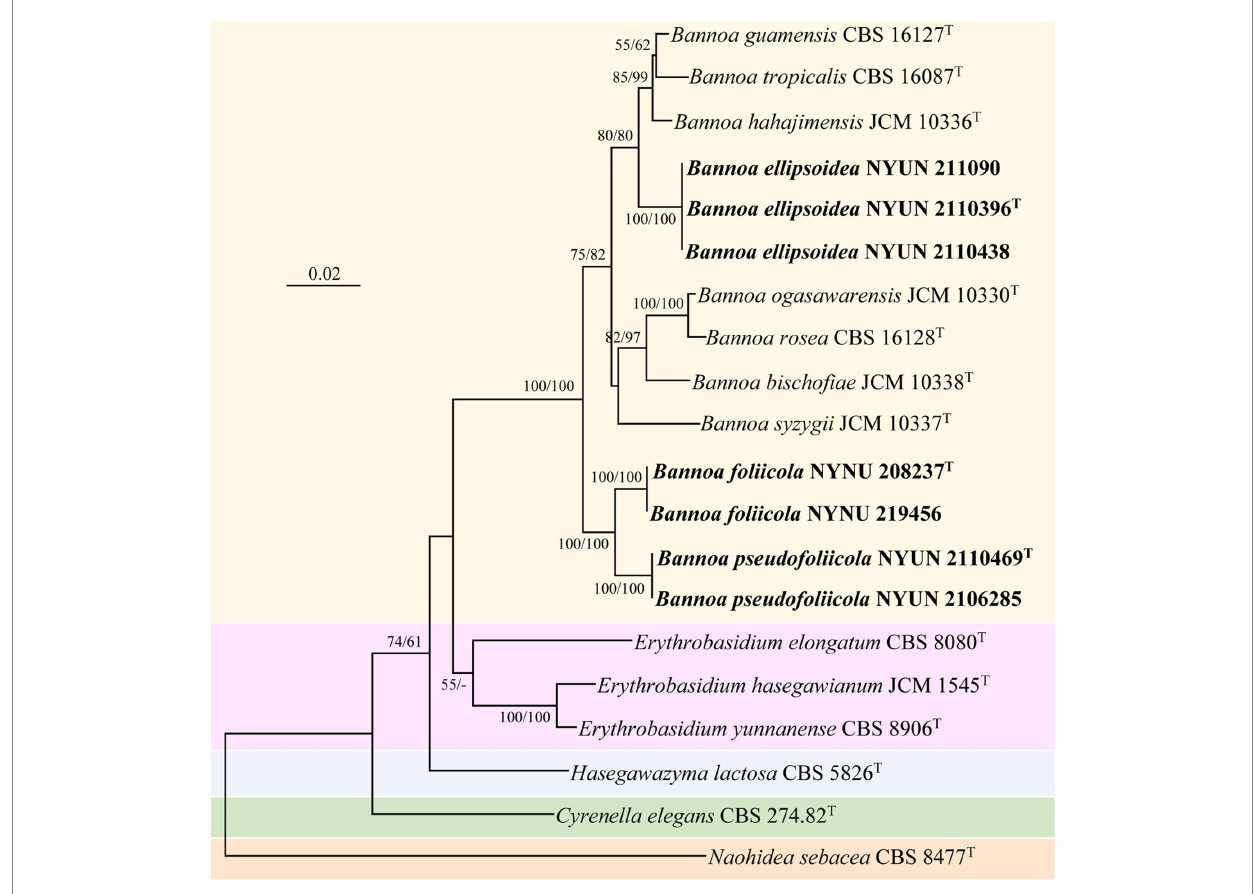
FIGURE 2 Maximum likelihood (ML) phylogram of Bannoa species based on the combined SSU + ITS + LSU D1/D2 + tef1 sequence dataset. Naohidea sebacea CBS 8477 T was used as the outgroup. ML and neighbor-joining (NJ) bootstrap support values above 50% are shown at the nodes (ML/NJ). The novel strains described in this study are shown in bold.